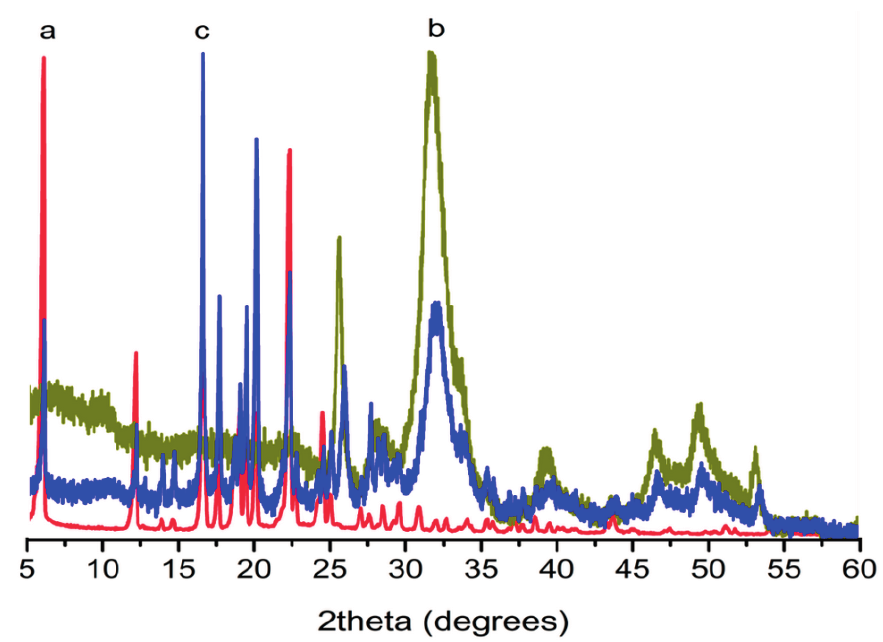
Figure 3. XRD patterns for (a) pure ibuprofen; (b) as-HAP (HAp284PA); and (c) ibuprofen-HAp mixture